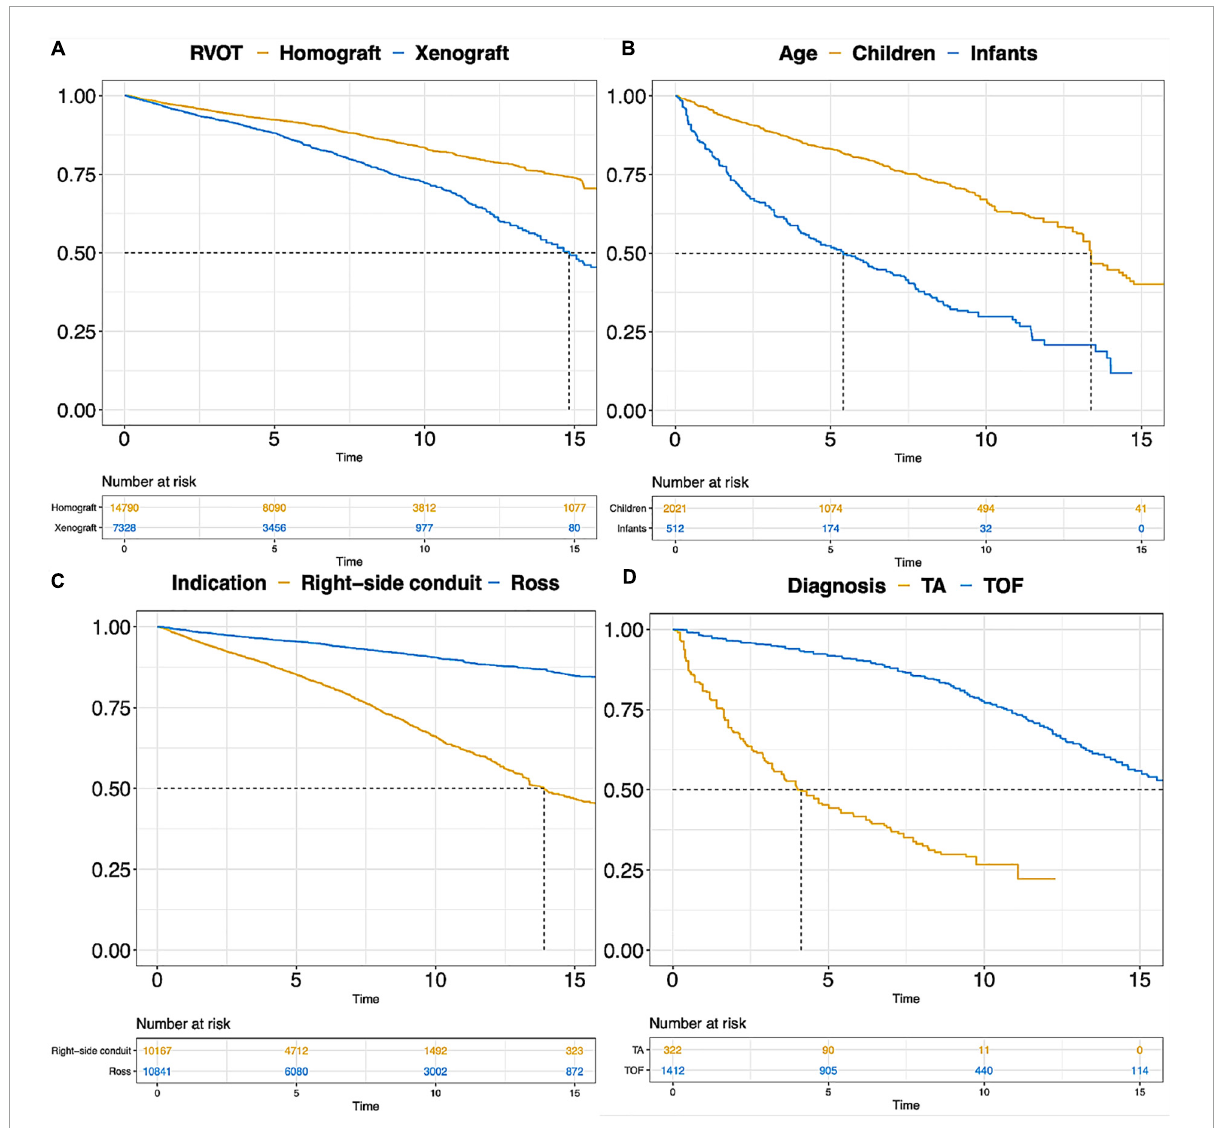
FIGURE4 Pooled Kaplan-Meier curves of freedom reintervention in different subgroups. (A) Freedom from reintervention in subgroups of RVOT with homograft and RVOT with xenograft; (B) freedom from reintervention in subgroups of children and infants; (C) freedom from reintervention in subgroups of “Ross” and “Right-sided conduit”; (D) freedom from reintervention in subgroups of patients diagnosed with TA and TOF. TA, truncus arteriosus; TOF, Tetralogy of